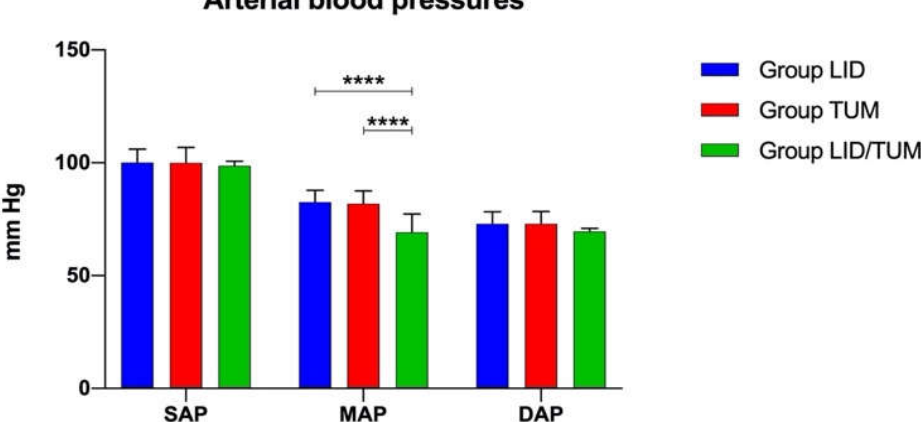
Figure 2. Mean values ± standard error of invasive systolic (SAP), diastolic (DAP) and mean (MAP) arterial blood pressures during anesthesia procedures in the three groups. LID: Lidocaine group; TUM: Tumescent anesthesia group; LID/TUM: Lidocaine/Tumescent anesthesia group. Asterisks indicate significant differences between groups, ****: p < 0.0001.